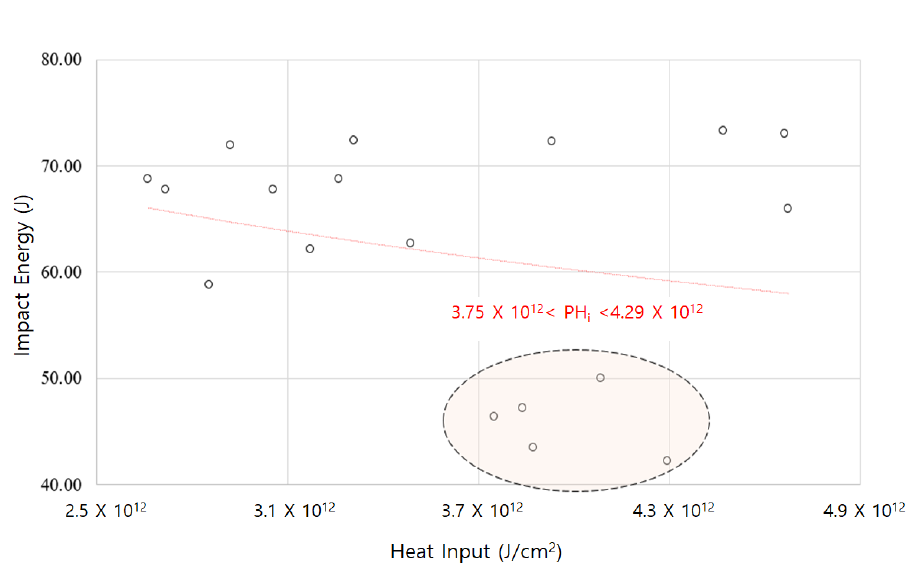
Figure 7. Impact energy distributions according to heat input in flux core arc welding.